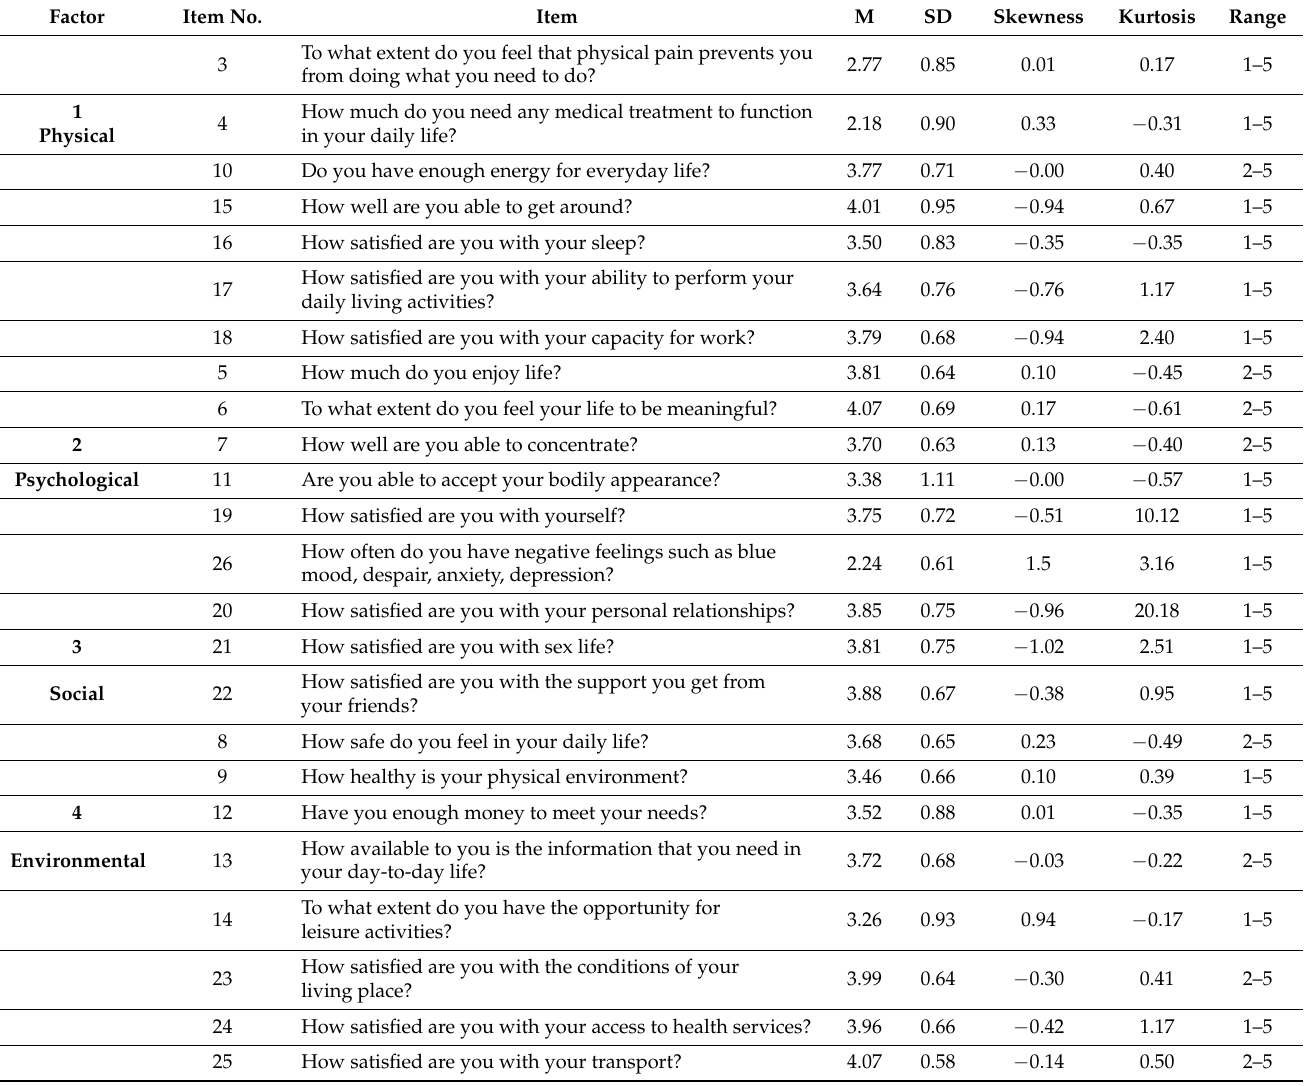
Table 4. Normality test findings.